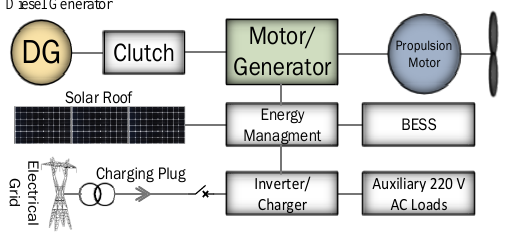
Figure 20. Schematic diagram of hybrid yacht by Greenline 33 .